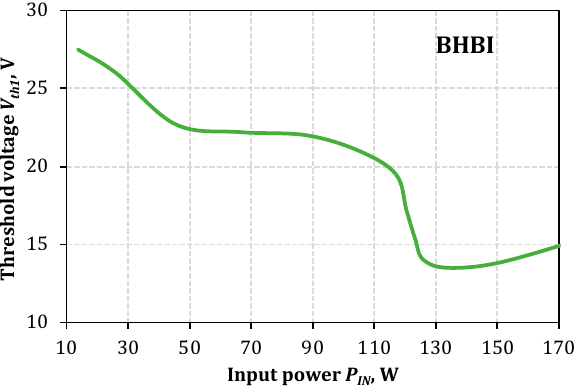
Figure 10. Dependence of the threshold voltage V th 1 on the input power in the converter with BHBI.